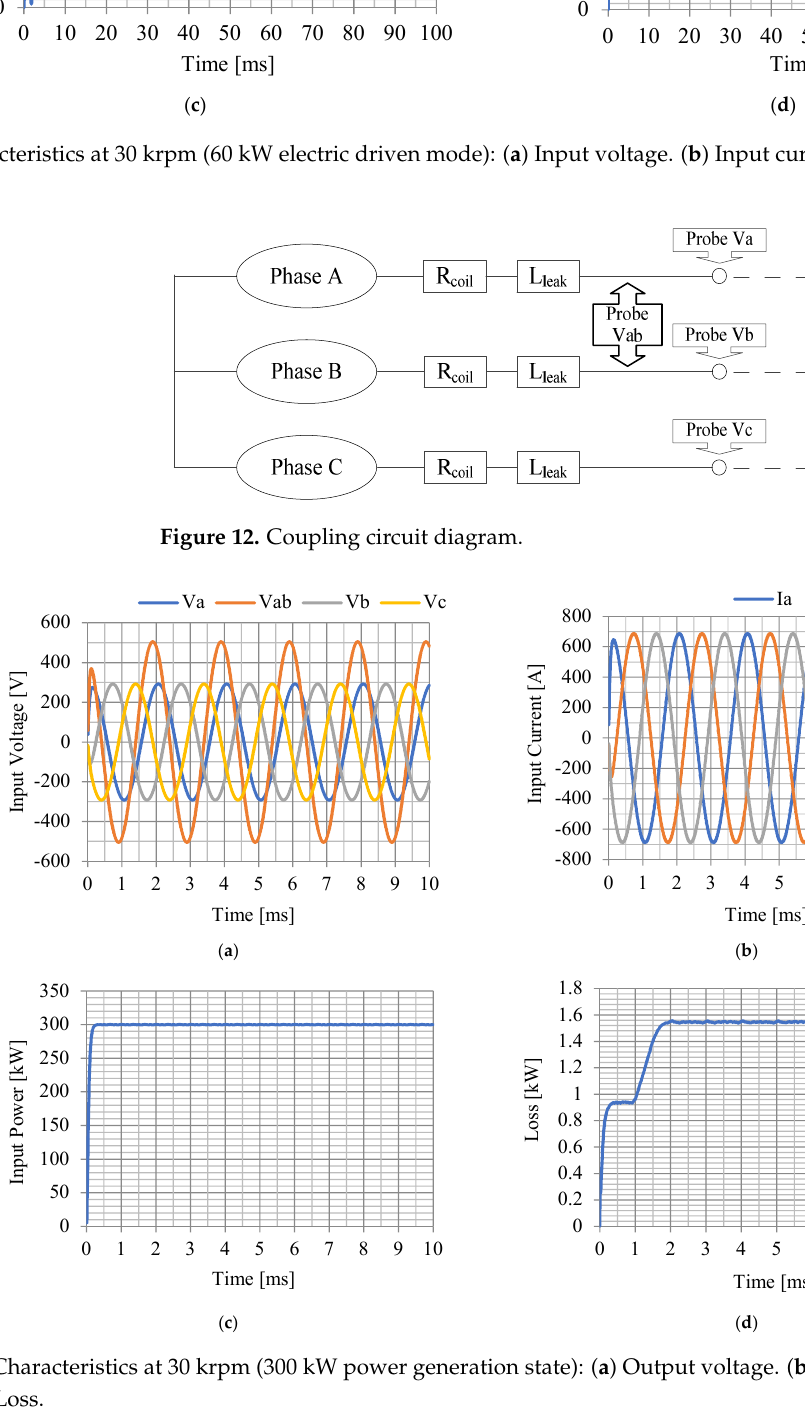
Figure 11. Characteristics at 30 krpm (60 kW electric driven mode): ( a ) Input voltage. ( b ) Input current. ( c ) Input power. ( d ) Loss.